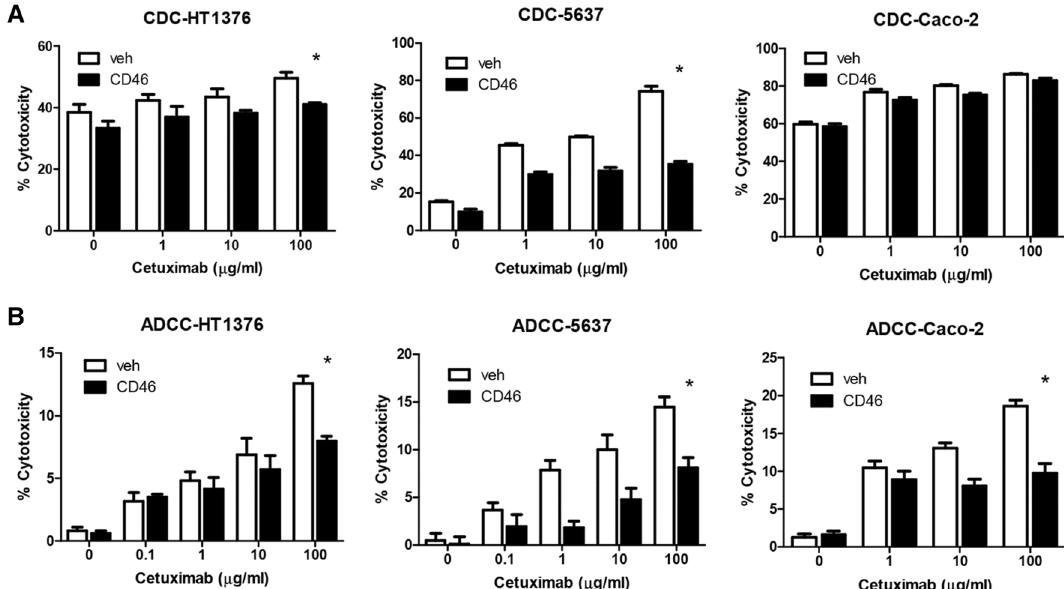
Figure 4. Protection of the bladder cancer cells from cetuximab-mediated cytotoxicity through both ADCC and CDC by CD46. Using HT1376, 5637, and Caco-2 cells, effects of CD46 on cetuximab-mediated CDC ( A ) and ADCC ( B ) were determined as described in “Materials and methods”. Caco-2 colon cancer cells were used as the reference cells. Experiments were repeated three times and results are expressed as mean ± standard deviation. *p < 0.05 (two-tailed student